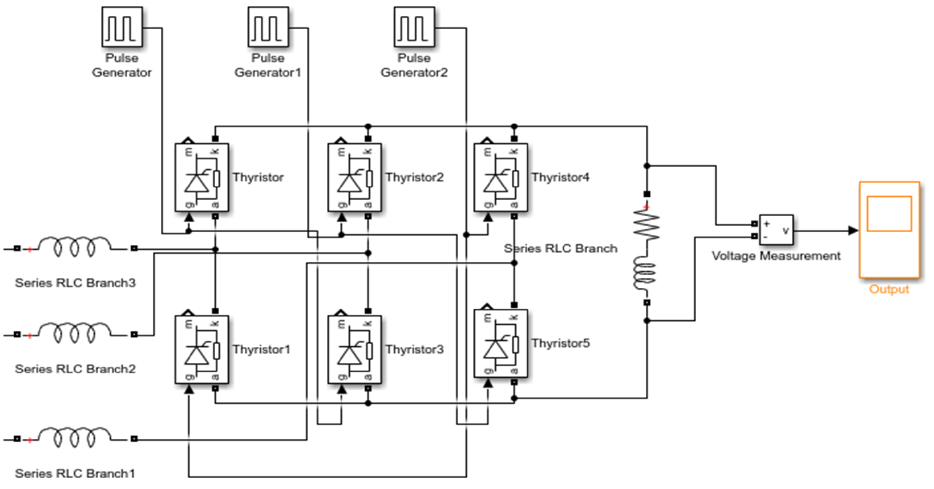
Figure 7. Thyristor based model of electrical vehicle